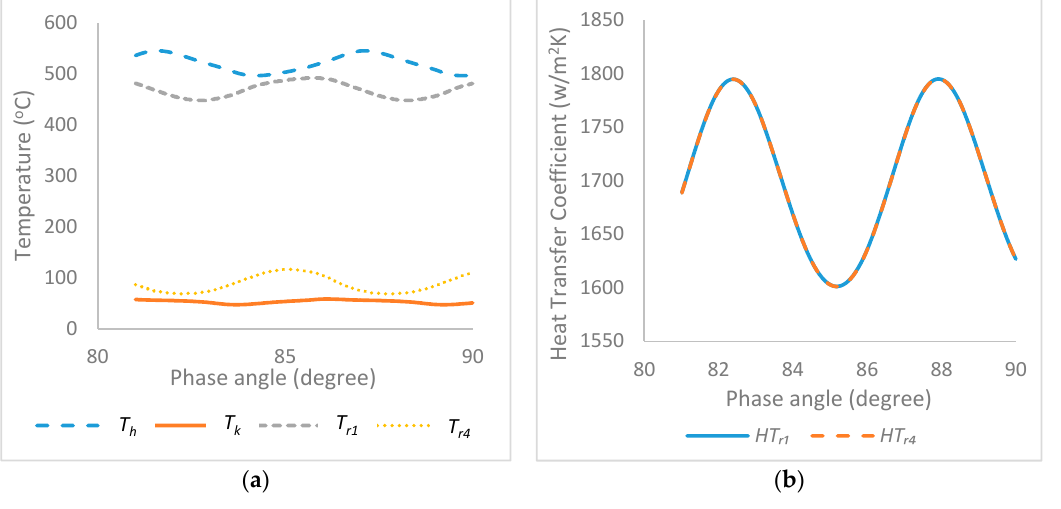
Figure 6. ( a ) Temperature distribution in the heat exchangers; ( b ) Heat transfer coefficient in the regenerator.